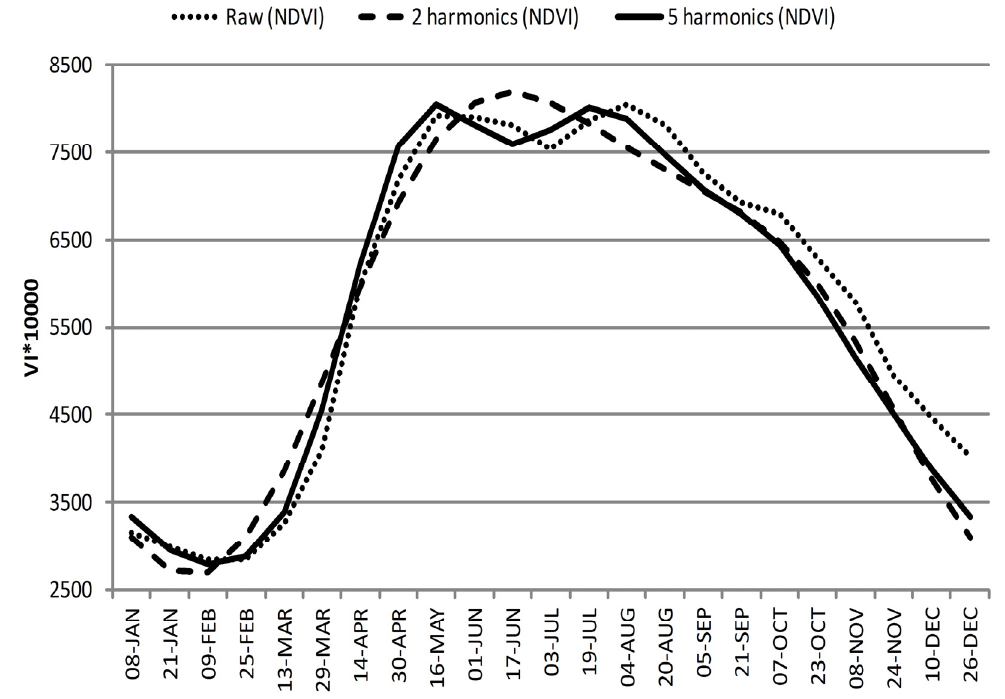
Figure 5. The effect of Fourier adjustments by using different levels of Fourier terms on temporal profile of